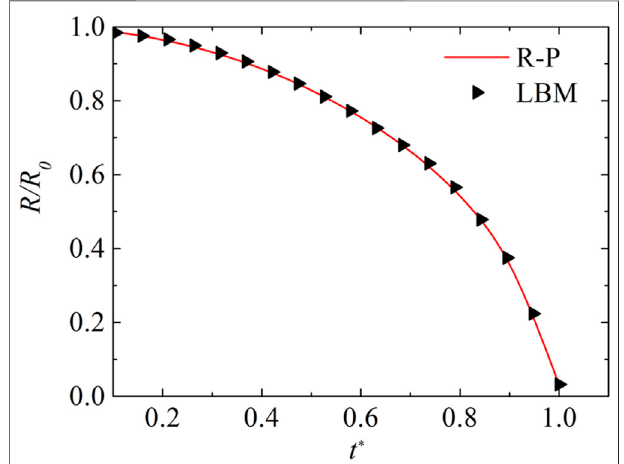
FIGURE 2 | Evolution curve of collapsed bubble